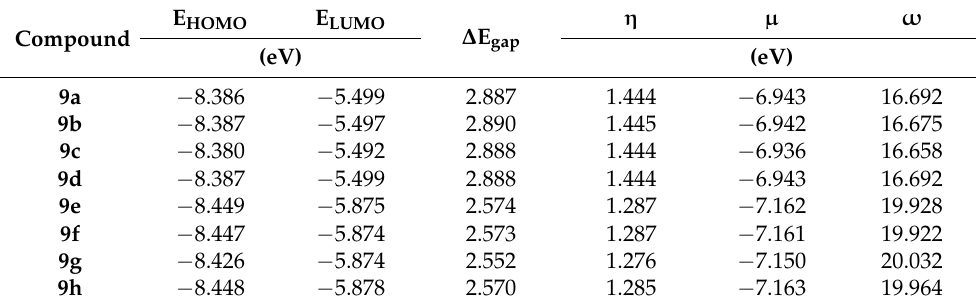
Table 7. The HOMO, LUMO energies and molecular descriptors of compounds 9a – h .